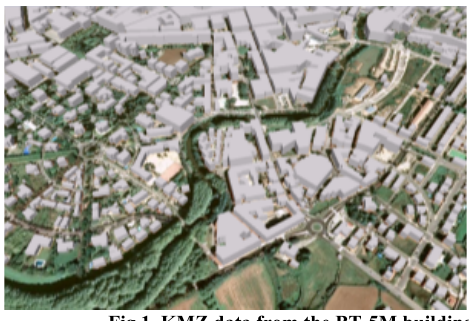
Fig 1. KMZ data from the BT-5M buildings